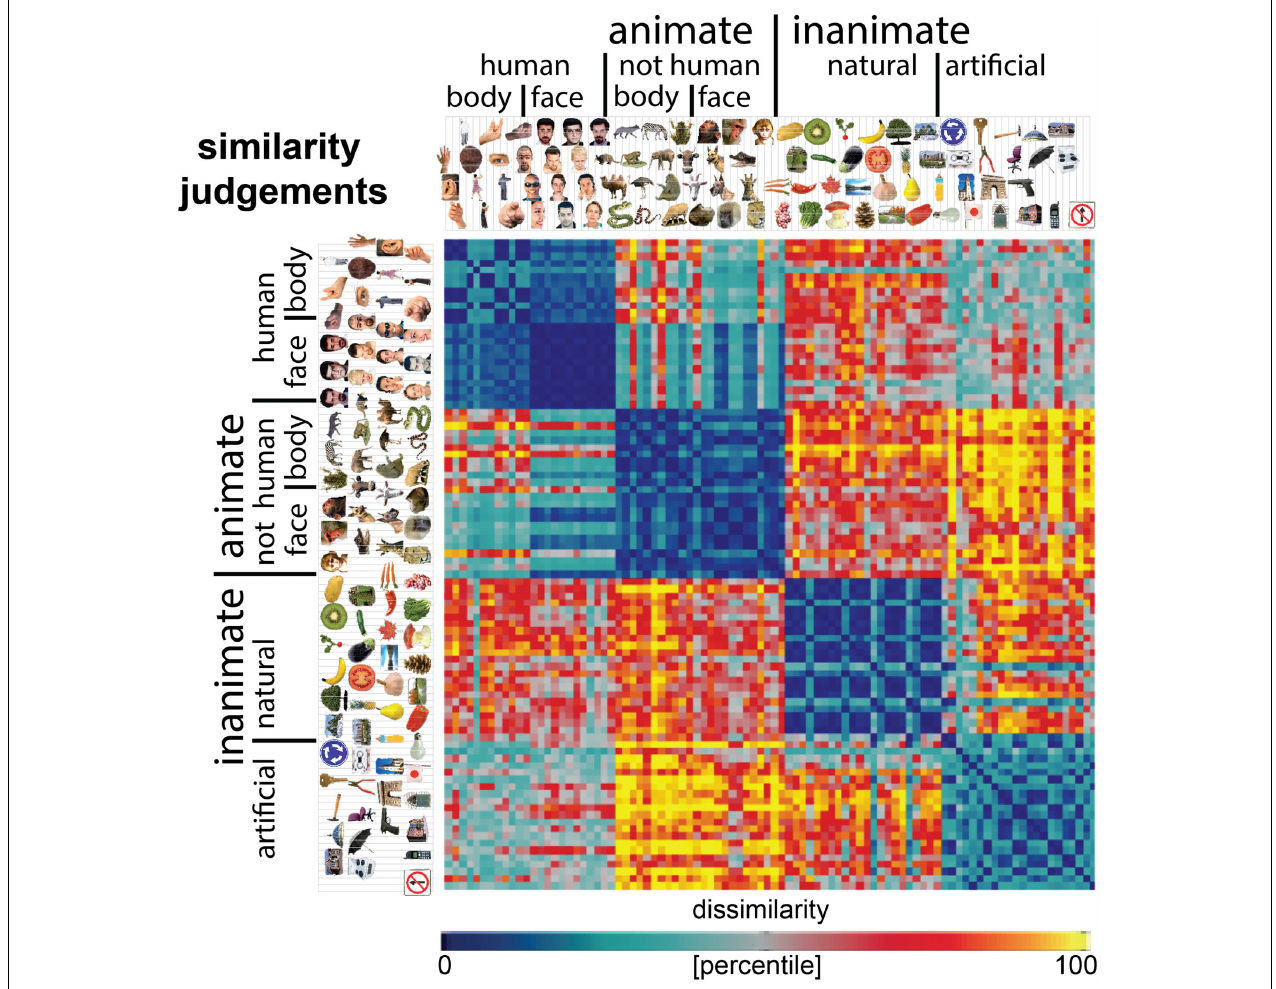
FIGURE 1 | Similarity-judgment RDM. Representational dissimilarity matrix (RDM) showing object-similarity judgments for a set of 92 colored object images. The RDM is based on similarity judgments from 16 human participants, averaged at the level of the dissimilarities. Each entry of the RDM represents the judged dissimilarity between two images. RDM values were transformed into percentiles for visualization (see color bar). The similarity judgments show four main clusters corresponding to humans, non-human animals, natural objects, and manmade objects, and a tight cluster of human